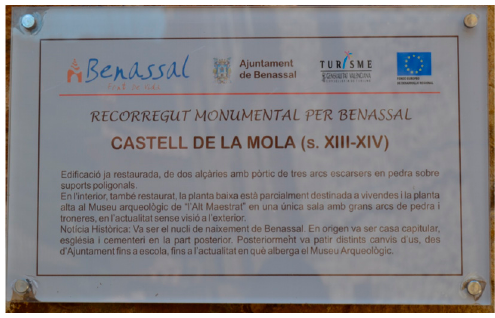
Figure 2. Benasal: Valencian-only sign on a castle.